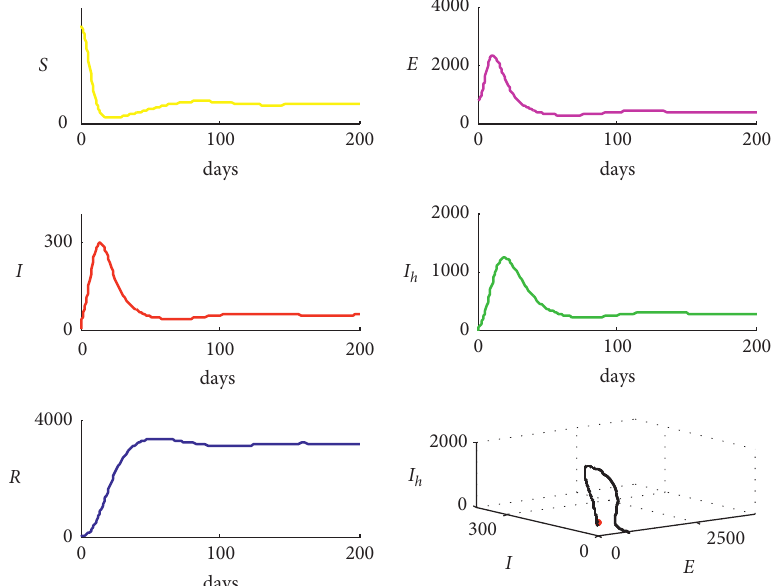
Figure 4: The trajectory of system (1) approaches to endemic equilibrium point for the data in Table 2 with c � 0 . 9 and b